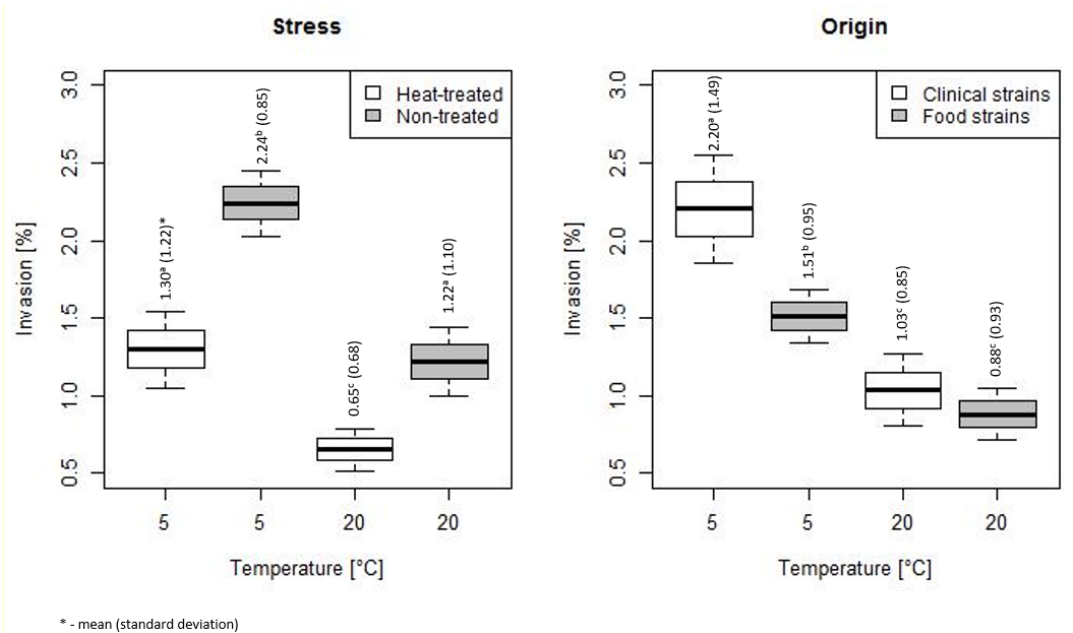
Figure 6. The invasiveness of HT and NT bacteria, and for bacteria from food and clinical samples, stored at 5 and 20 °C (the horizontal line is the mean, the box spans represent standard error and the whiskers represent 95% confidence interval).